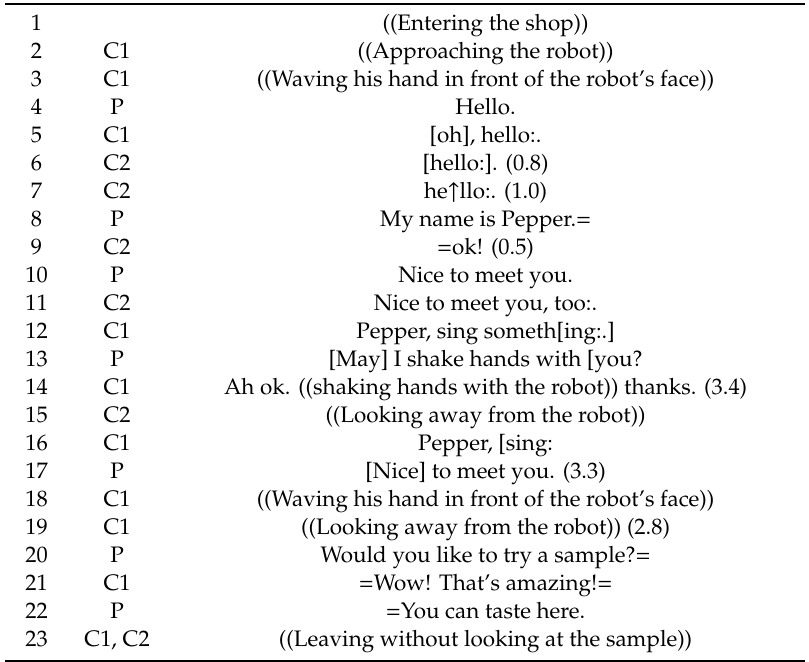
Table 6. Conversation with a group that did not look at the sample or taste it after the robot’s o ff er (5 December 2017).